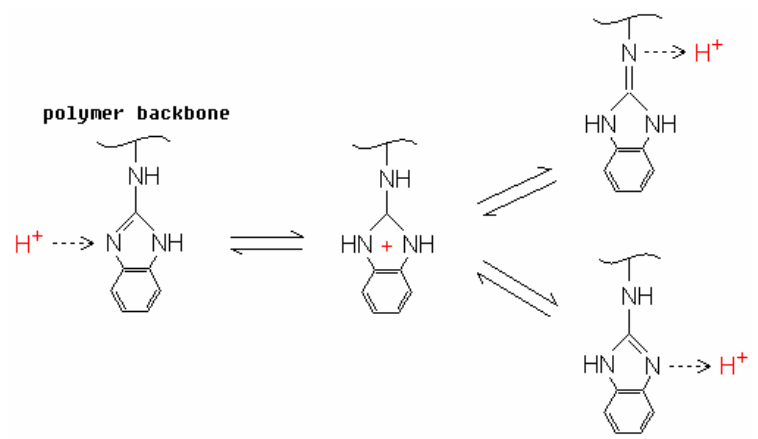
Figure 10. Possible proton transfer in the SPEEK/PSf-ABIm blend membranes. (Reprinted with permission from [56]. Copyright 2007 Elsevier). Where PSf-ABIm is polysulfone-2- amide-benzimidazole.